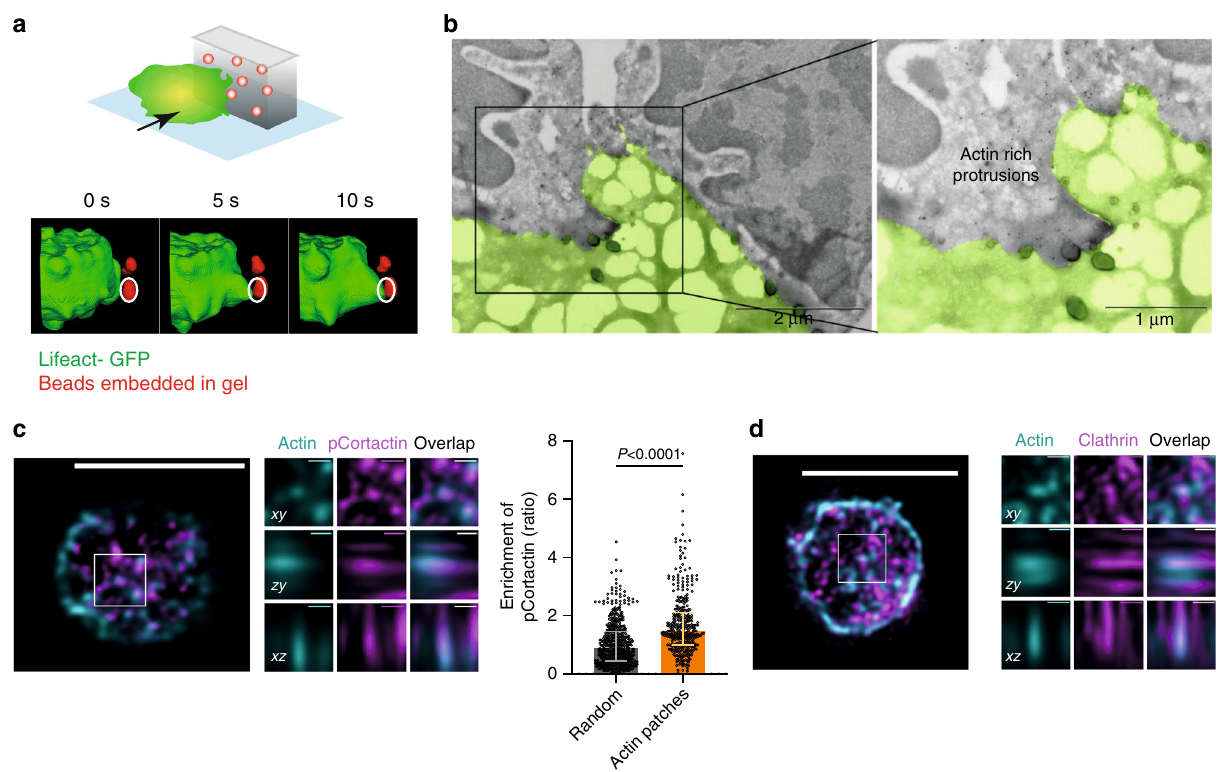
Fig. 6 Characterization of actin patches. a Protrusions associated with bead movement (red) on antigen-coated gel pieces presented laterally to B cell (green), 3D reconstruction. b Electron microscopy image showing actin-rich protrusions (marked by gold beads) through PAA gel (scale bar 0.2 µ M ). c Immunostaining of actin (cyan) and phospho-cortactin (magenta) and zoomed orthogonal projections on different planes (scale bar 5 µ m, zoom 0.5 µ m); images show colocalization (quantify on the right as ratio of magenta signal in the cyan region, control is the enrichment of the signal in random position, Median ± IQR, 26 cells, two independent experiments, two mice, Mann – Whitney test). d Immunostaining of actin (cyan) and clathrin (magenta) and zoomed orthogonal projections on different planes (scale bar 5 µ m, zoom 0.5 µ m); images show partial colocalization (not quanti fi ed, scale bar 5 µ m, zoom 0.5 µ m). Source data are provided as a Source Data fi